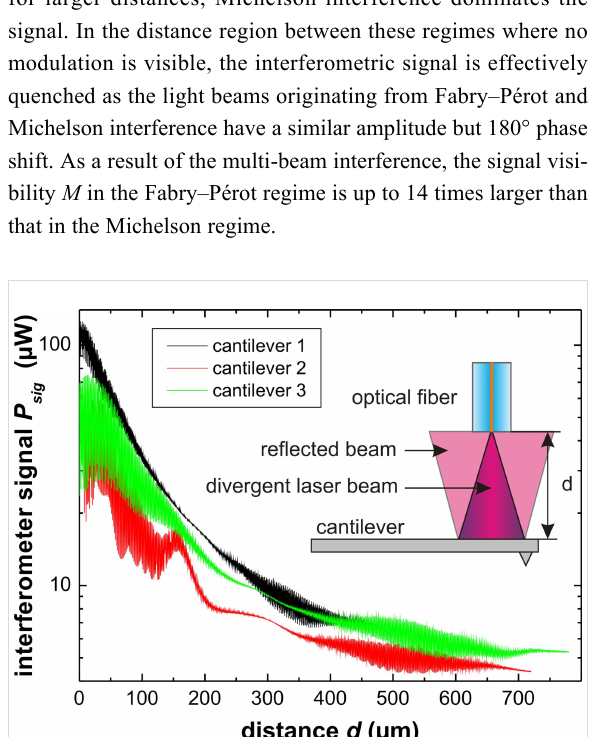
Figure 5: Signal power over distance measurements for three differ- ently positioned cantilevers. Cantilever 1 has high optical loss,